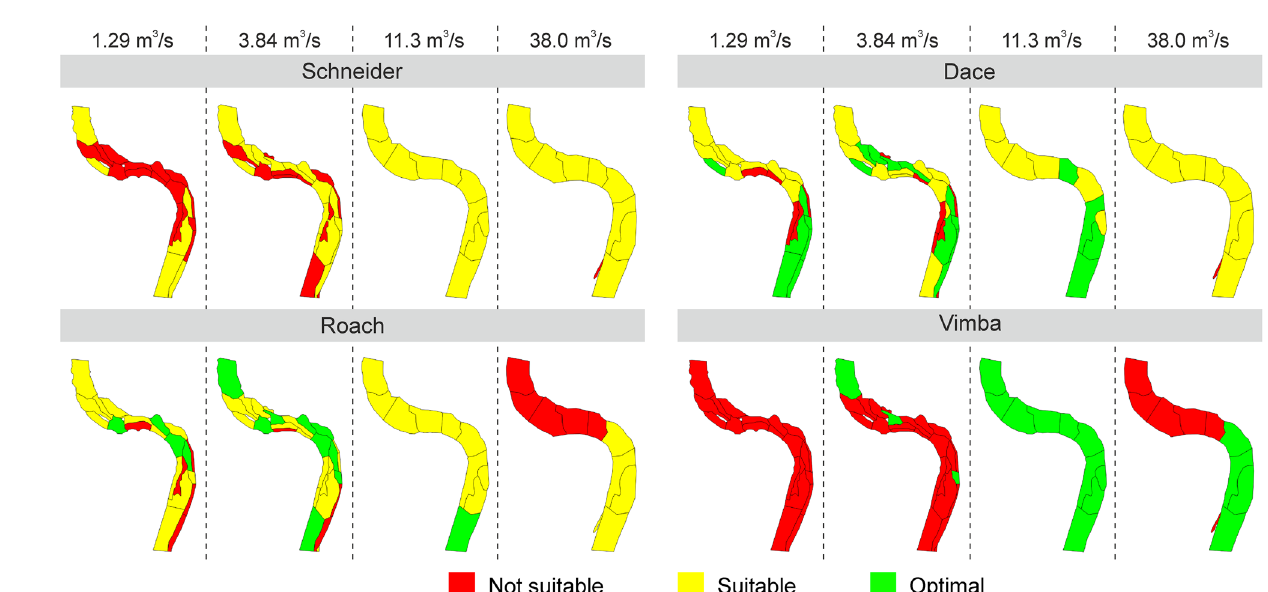
Figure 5. Habitat suitability maps of four fish species in Venta-Kuodžiai case study at four different discharge (m 3 /s)